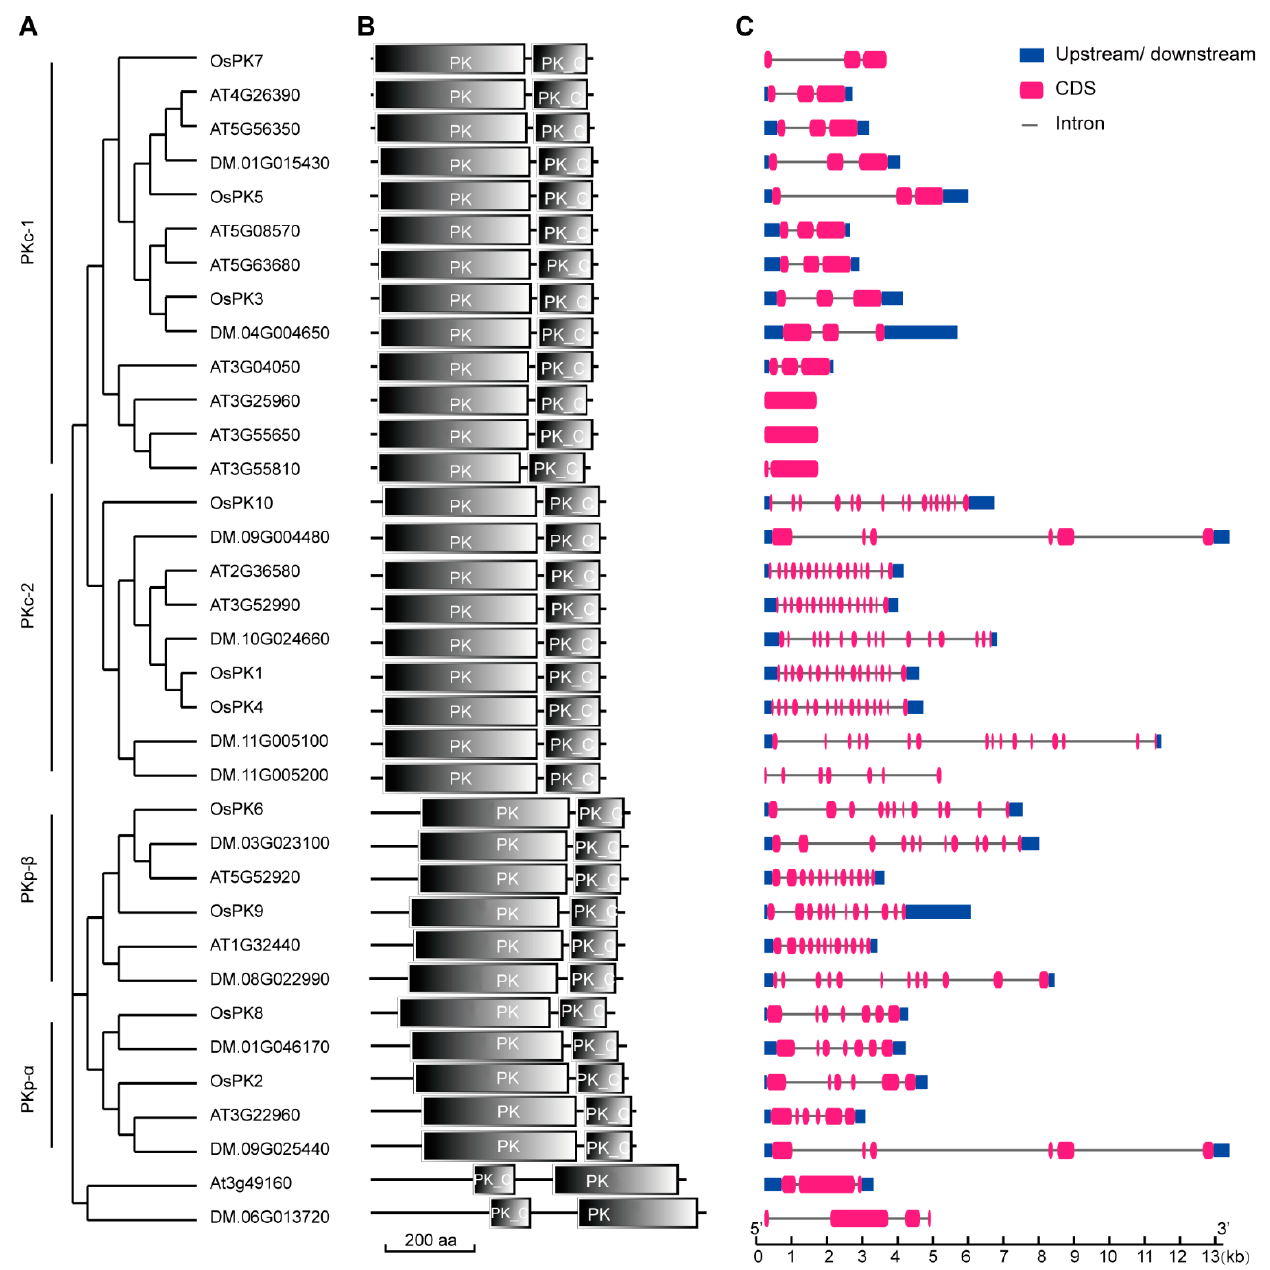
Figure 1. Phylogenetic, motif, and gene structure analyses of PK genes. ( A ) Phylogenetic analysis of PK genes in rice, Arabidopsis , and potato. ( B ) Motif analysis of PKs. The scale at the bottom can be used to estimate the lengths of PK proteins. ( C ) Gene structure analysis of PK genes. The pink color represents the exon region, the black line represents the intron region, and the blue color represents the noncoding region. The scale at the bottom can be used to estimate the lengths of PK genes.